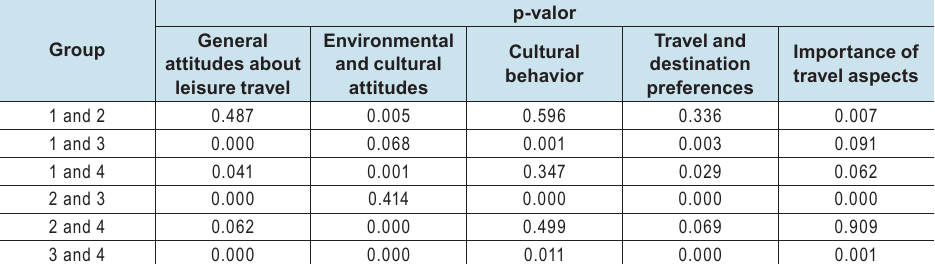
TABLE 2. Mann-Whitney U test and significance by groups of visitors of the territory of the Serra do Sincorá Geopark Project, Lençóis, Bahia. Significance by groups is identified when the p-value is <0.05 and is highlighted with gray color.